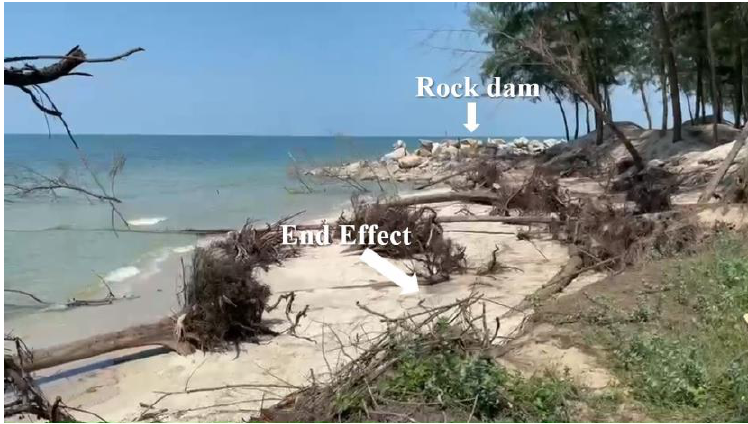
Figure 2. The end effect at Khao Rup Chang beach, Thailand.